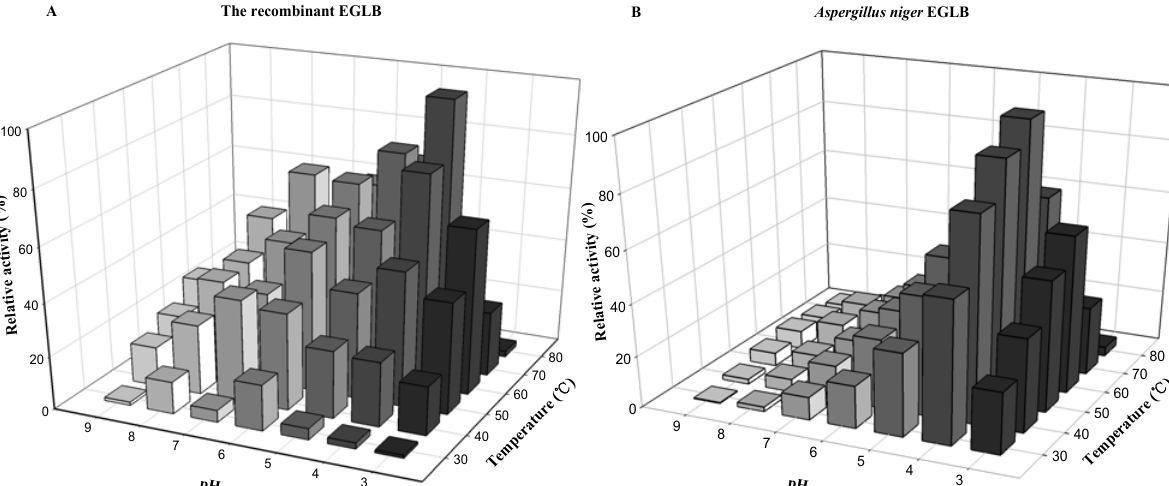
Figure 4. Optimum temperature and pH of the purified EGLB. The optimal temperature and pH for EGLB were determined by incubating the purified enzyme in different buffers (50 mM, pH 3.0 to 9.0) and then exposing them to different temperatures (from 30 °C to 80 °C) with CMC-Na (0.5%, w/v) as substrate for 30 min. Each enzymatic reaction was determined by the standard enzyme method (Section 3.11). Each value represents the mean of triplicate measurements, and varied from the mean by not more than 10%. The